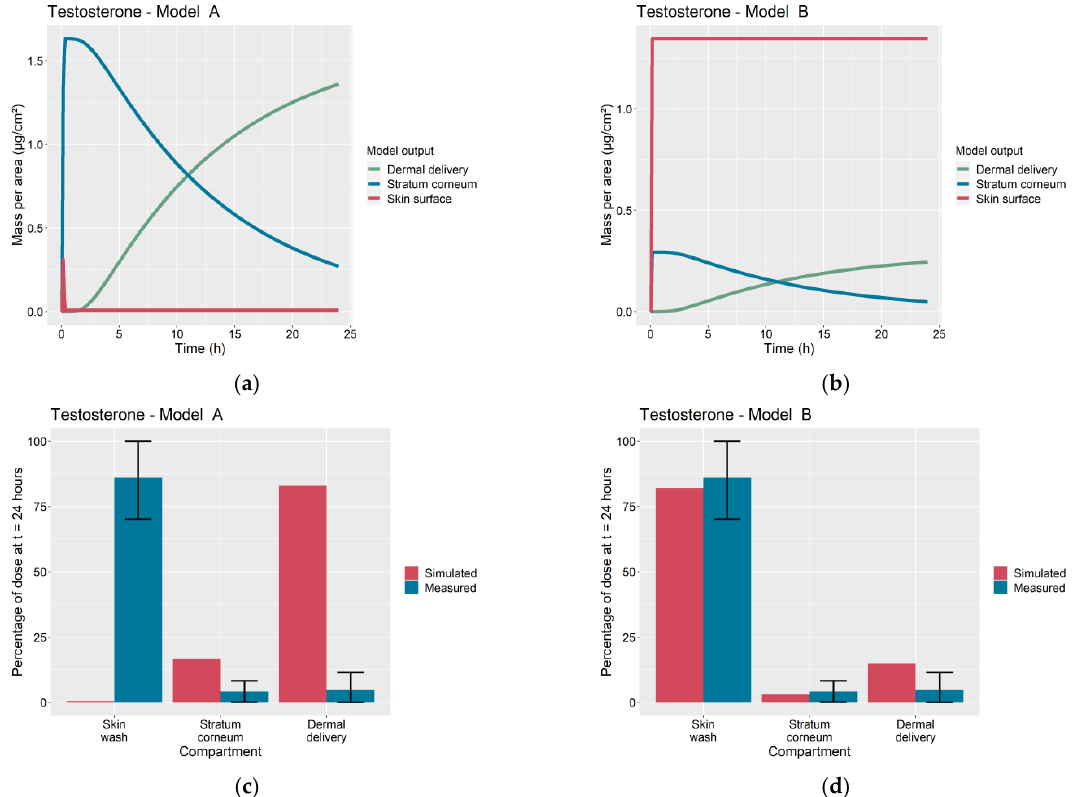
Figure 6. Comparison of Model A and Model B simulations of dermal absorption of testosterone. Time profiles of permeant mass per area on skin surface, accumulated in stratum corneum and dermally delivered for ( a ) Model A and ( b ) Model B. Simulated and measured percentage of dose remaining in skin wash, accumulated in stratum corneum and dermally delivered at 24 h for ( c ) Model A, root sum of squares error (Table A4) 𝐸 𝑇𝑜𝑡𝑎𝑙2 = 615.5 , and ( d ) Model B, 𝐸 𝑇𝑜𝑡𝑎𝑙2 = 7.77 .